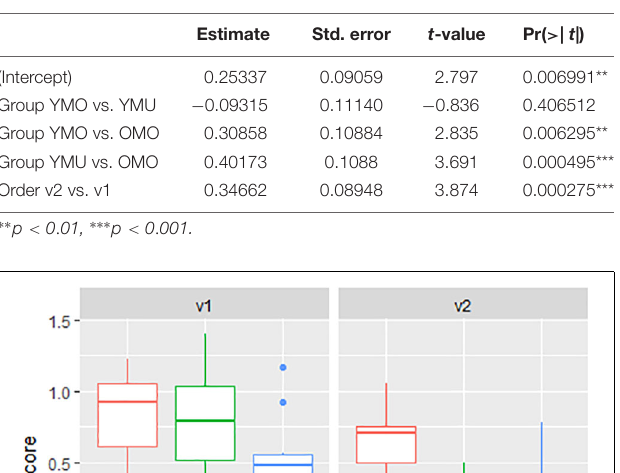
TABLE 5 | Summary statistics of the linear model with D -score as dependent variable and the influencing factors listener group and test order for the KD-experiment.